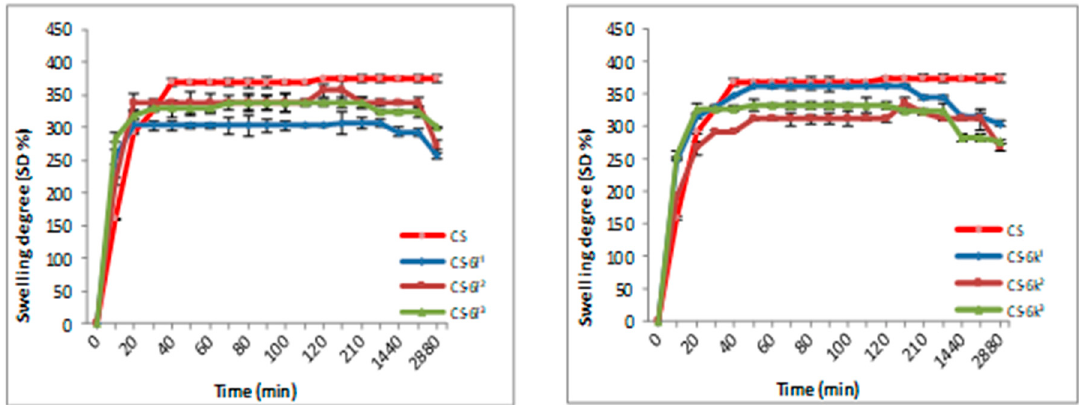
Figure 5. Swelling degree of CS and CS-XTDs (CS-6c; CS-6e) in SGF at different concentrations ( 1 = 3 mg/mL, 2 = 4 mg/mL, 3 = 5 mg/mL).